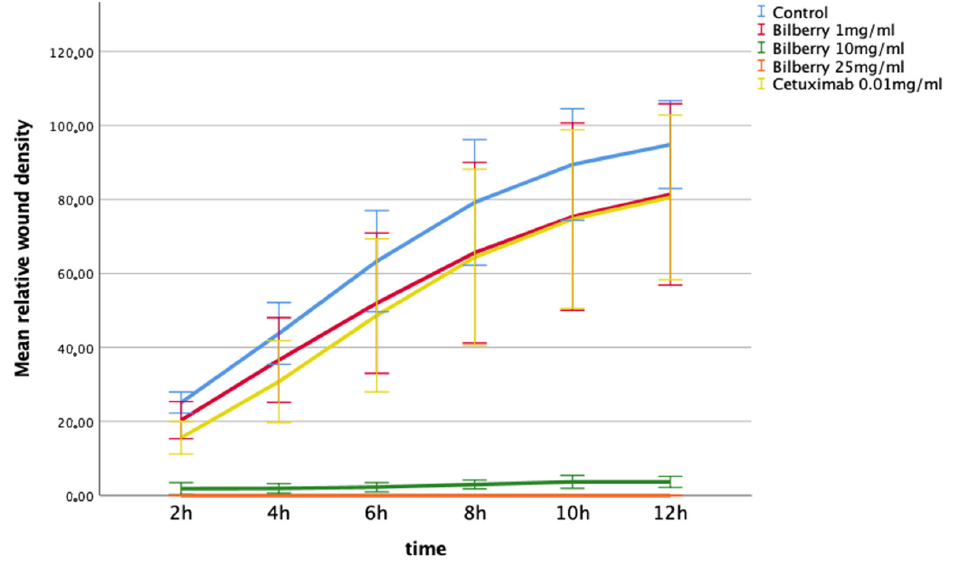
Figure 4. Invasion of HSC-3 cells in Myogel after 12 h of bilberry powder and cetuximab incubations. Mean relative wound density and 95%CI error bars.